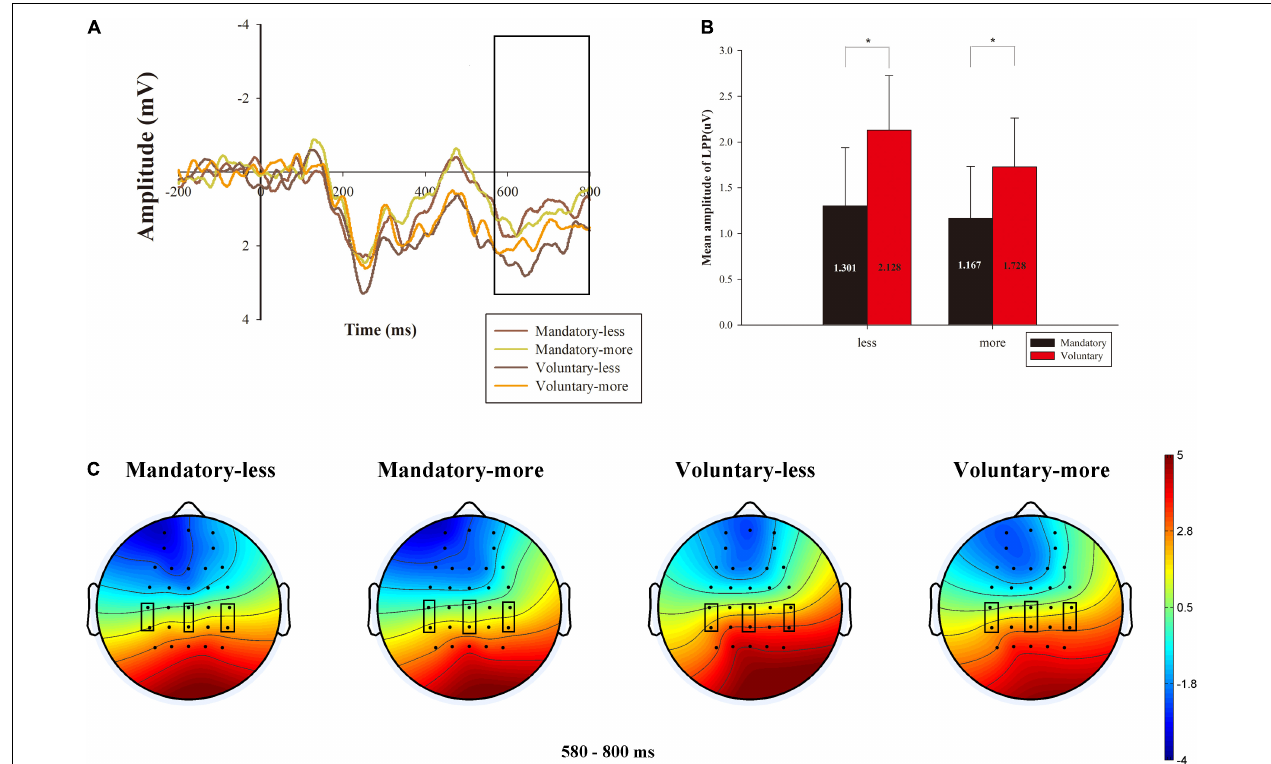
FIGURE 5 | Grand-averaged ERP waveforms of LPP about the average activity of all the electrodes, the mean amplitude of LPP and related brain topography. (A) LPP amplitude comparison of the four conditions of 2 donation contexts (mandatory vs. voluntary) × 2 amounts (less vs. more) about the average activity of all the electrodes. (B) The mean amplitude of LPP for the four conditions. (C) The brain topography of the four conditions and contrast at the LPP time window of 580 ∼ 800 ms. * p <